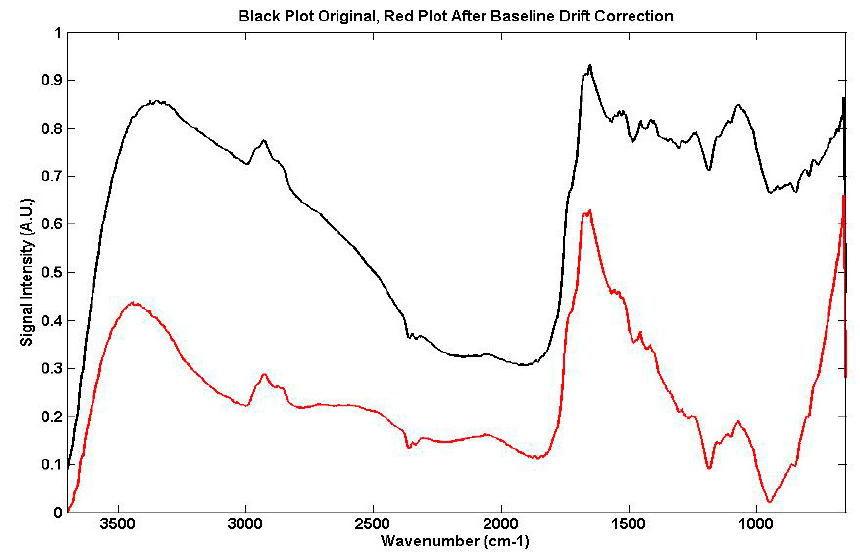
Figure 4. Example of a spectrum before (black) and after baseline drift correction (red) using the selection point method.